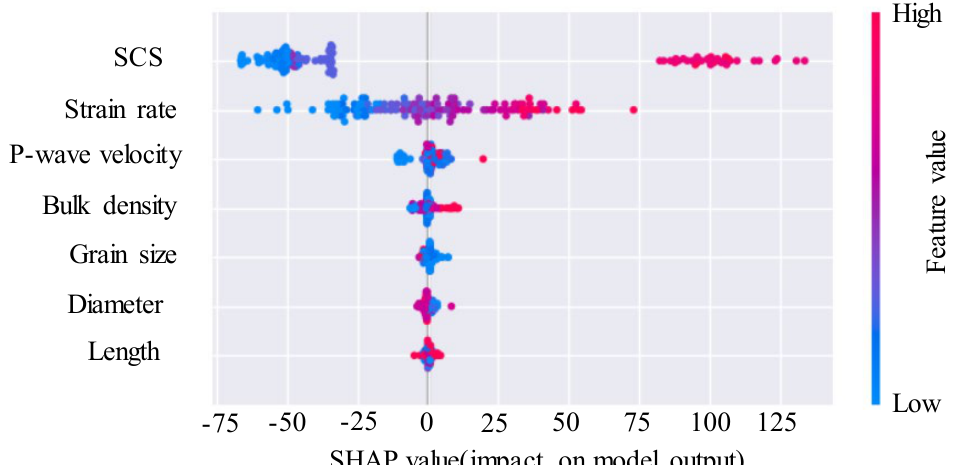
Figure 7. Three-dimensional pie chart of the relative importance of parameters to output.